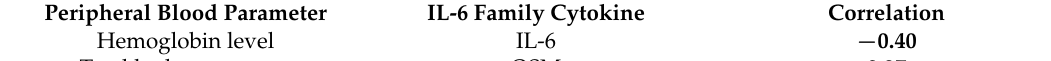
Table 3. Correlation between preconditioning serum levels of soluble mediators and the peripheral blood cell counts tested before and following allotransplantation. The results are presented as the Spearman’s ρ and significant correlations ( p < 0.05) are highlighted in bold. ( Upper part ) Significant correlations between IL-6 family cytokine levels tested before conditioning therapy and peripheral Boblood cell counts tested before immediately before initiation of conditioning treatment; ( Lower part ) Correlations between preconditioning serum mediator levels and peripheral blood cell counts (neutrophils and platelets) tested after allotransplantation. Time to neutrophil engraftment was defined as peripheral blood neutrophils above 0.2 × 10 9 /L on three consecutive days and time to platelet engraftment as peripheral blood thrombocytes above 20 × 10 9 /L on three consecutive days without platelet transfusions. Preconditioning Peripheral Blood Cell Counts Peripheral Blood Parameter IL-6 Family